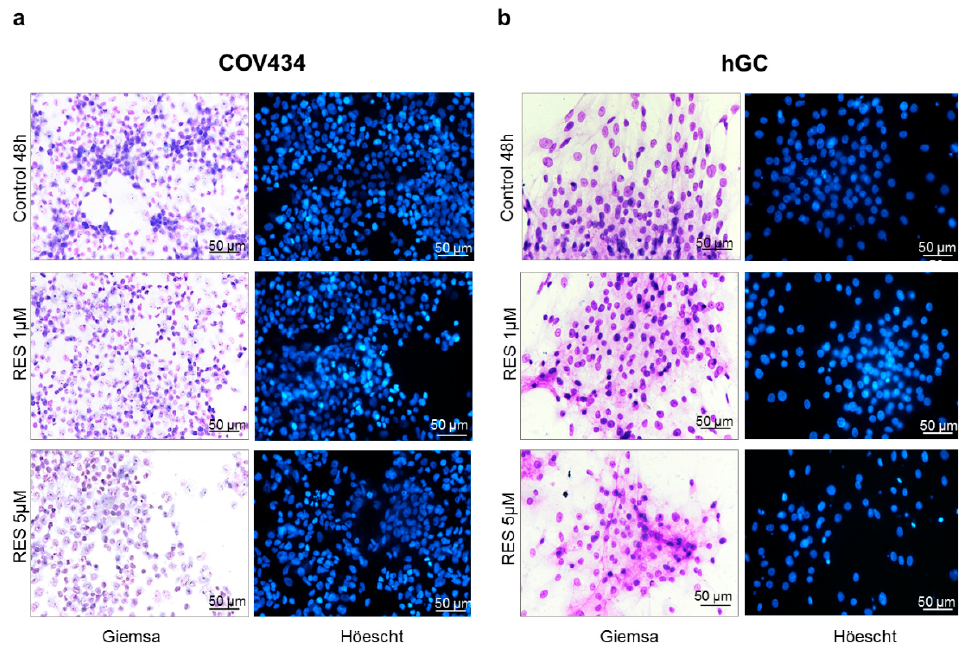
Figure 2. RES effect on COV434 ( a ) and hGC ( b ) morphology. Cell morphology and nuclei were analyzed after 48 h of treatment using Giemsa and Höechst staining, respectively, in the absence (control) and presence of RES (1–5 µ M). Results are shown from single representative of three independent experiments. Total magnification 200 ×.